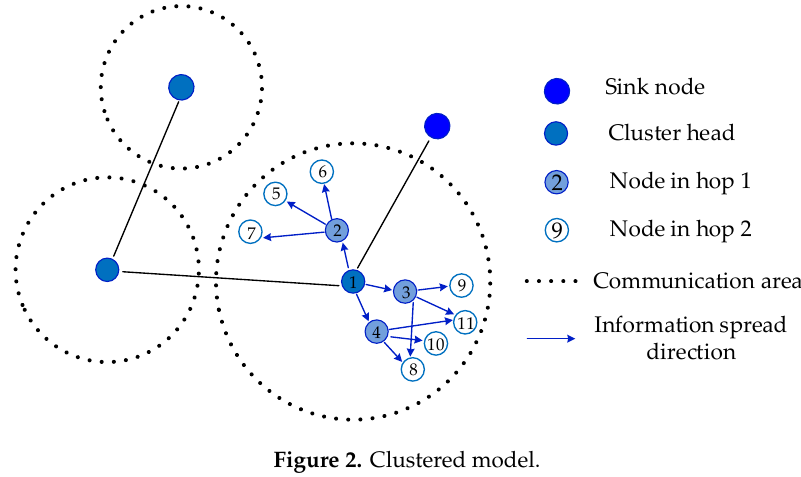
Figure 2. Clustered model.